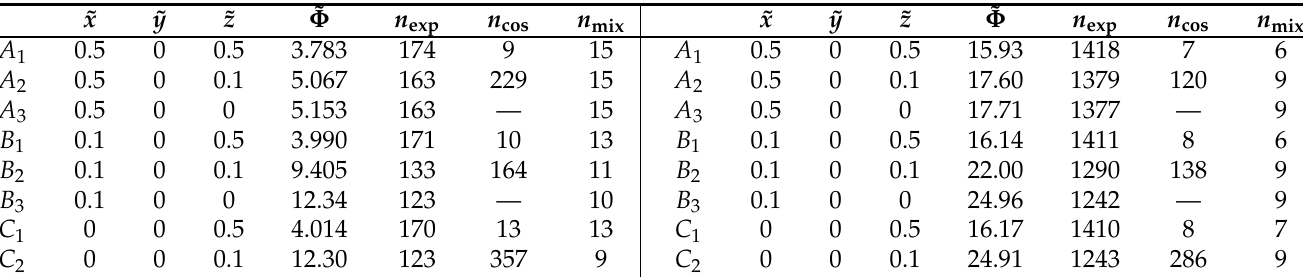
Table 2. Potentials ˜ Φ as well as the numbers n exp , n cos and n mix in a selection of points for ˜ λ eff = 1 and ˜ λ eff = 3 in the left and right tables, respectively.